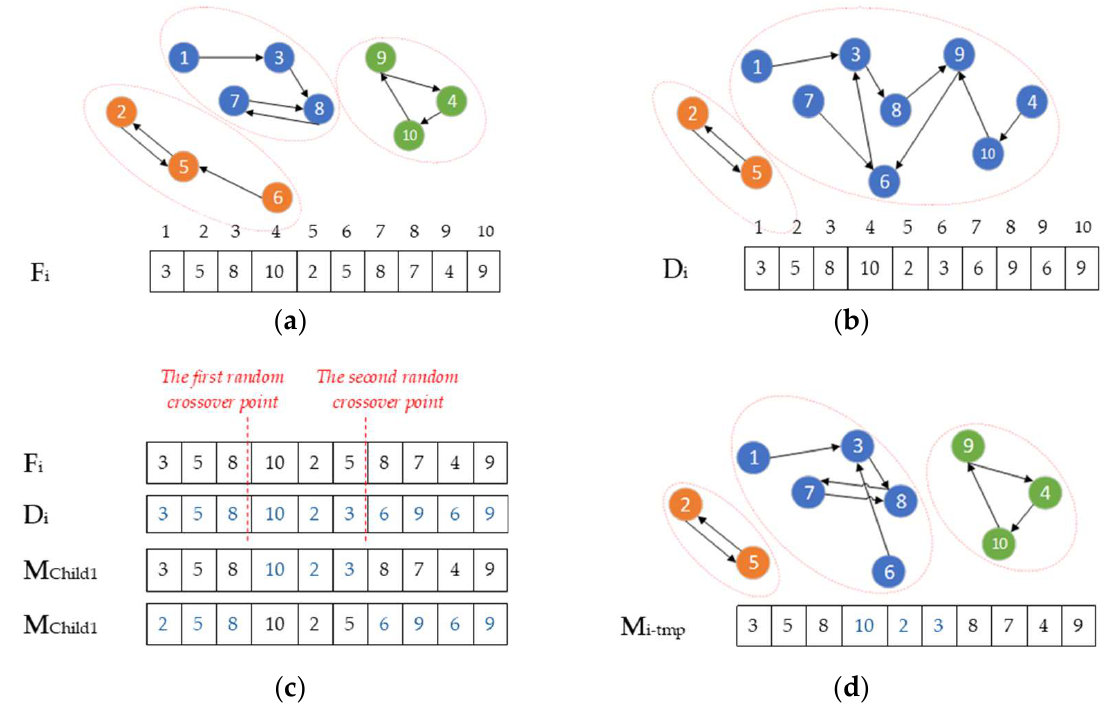
Figure 7. Generating new solutions using the two-point crossover: ( a ) solution vector F i and its communities; ( b ) solution vector D i and its communities; ( c ) generating M Child 1 and M Child 2 ; ( d ) M Child 1 with better fitness is selected as M i-tmp .